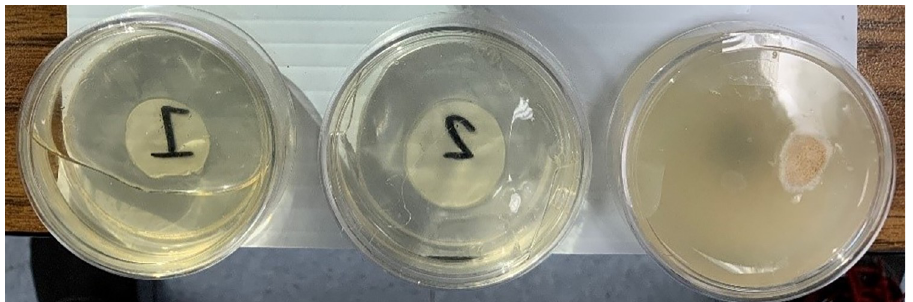
Fig 2. Representative photograph of an on-going bacteria resistance